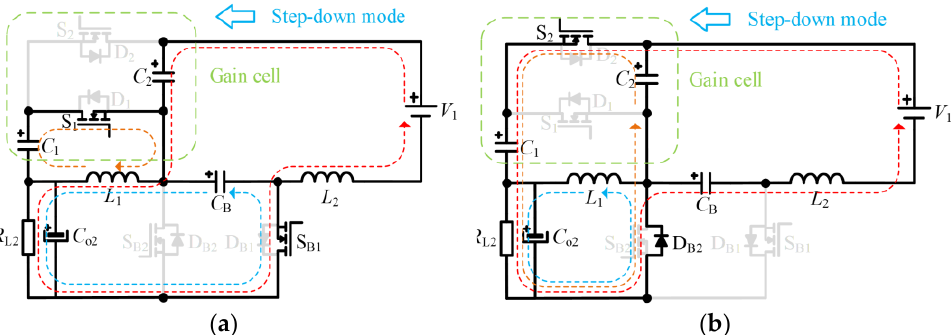
Figure 5. The equivalent circuit of the operation modes in step-down mode: ( a ) S B1 S 1 on, S 2 off; ( b ) S 2 on, S B1 S 1